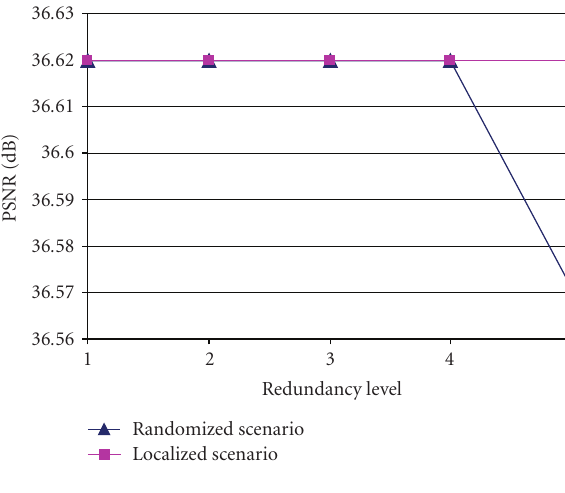
Figure 8: Packets loss ratio—Moderately loaded.